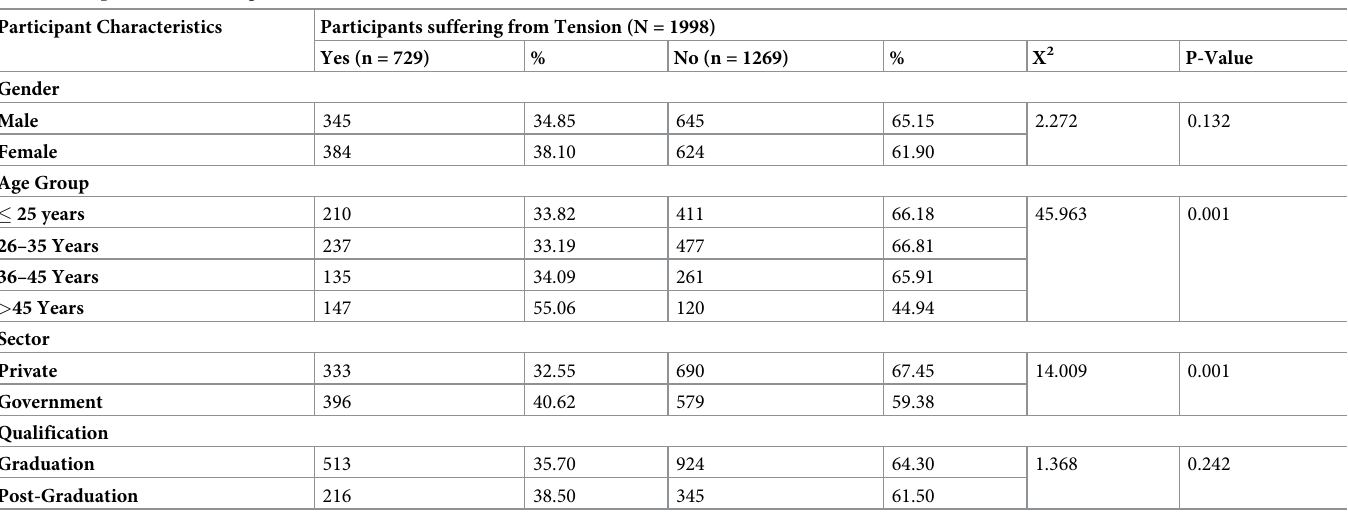
Table 6. Respondents suffering from tension.